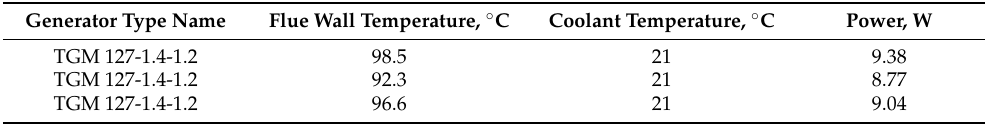
Table 6. Parameters of the dependence of the output power on the temperature of the heat transfer surface of the